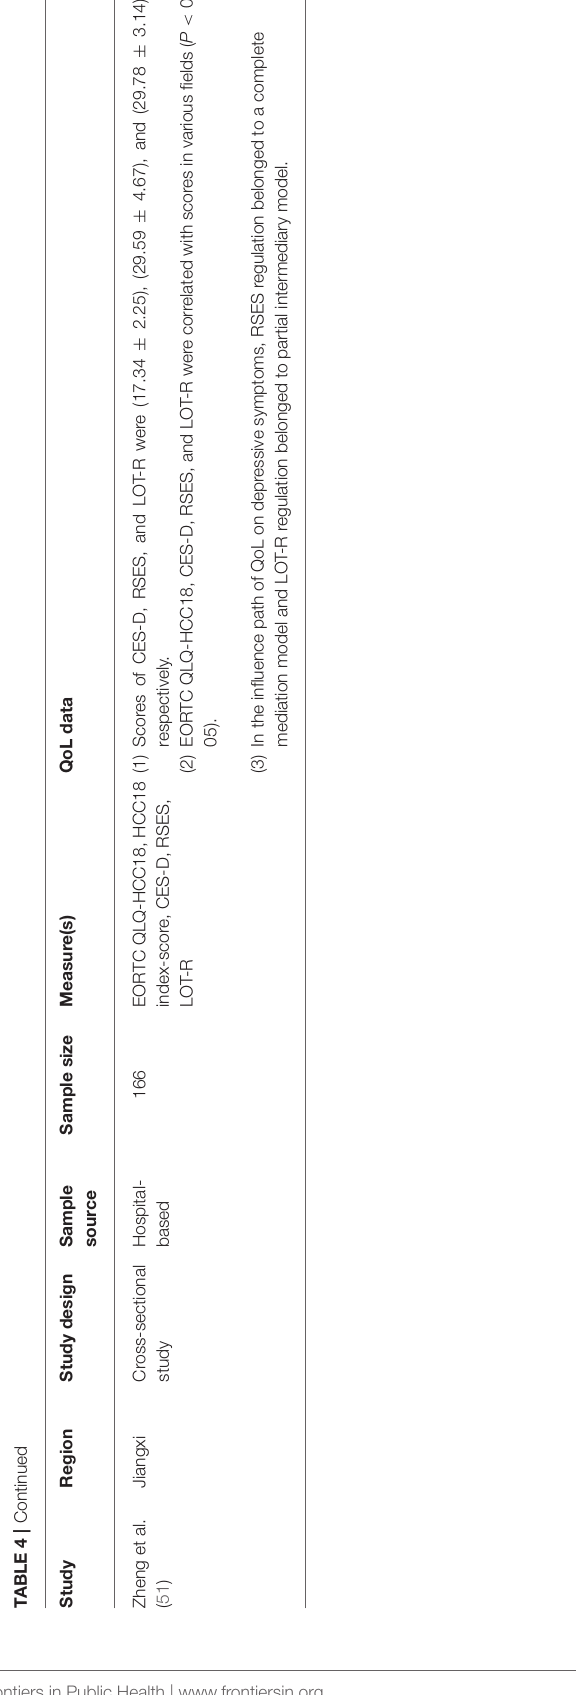
TABLE 5 | The pooled data and norms of the EORTC QLQ-C30 subscales.